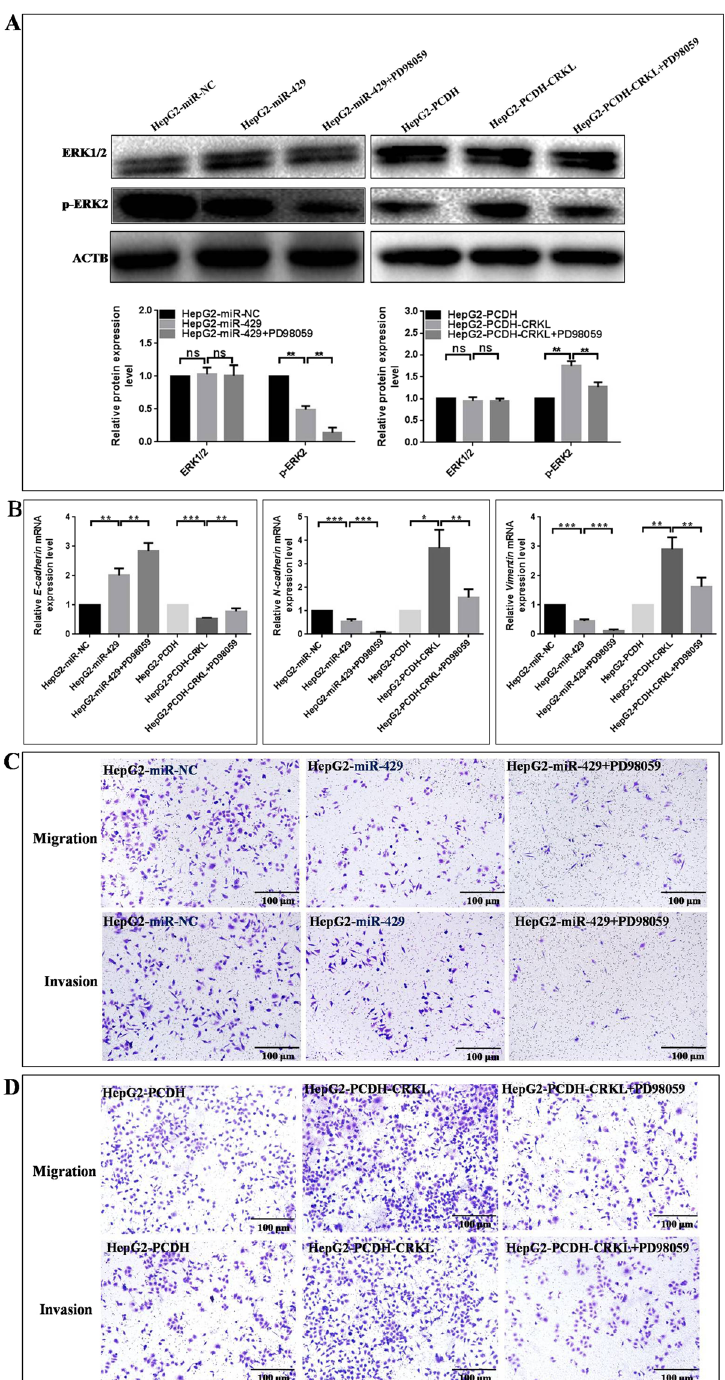
Figure 11. PD98059 influence on miR-429- and CRKL-induced Raf/MEK/ERK pathway and EMT. ( A ) WB assay of ERK and p-ERK2 level changes in HepG2-miR-429 and HepG2-PCDH-CRKL cells with PD98059 treatment for 48 h. ( B ) qRT-PCR assay of E-cadherin, N-cadherin, Vimentin changes in HepG2-miR-429 and HepG2-PCDH- CRKL cells with PD98059 treatment for 48 h. The influences of PD98059 on migration and invasion abilities of HepG2-miR-429 ( C ) and HepG2-PCDH-CRKL cells ( D ) *** and *** refer to the level changes were in statistical significances with P < 0.05, 0.01 and 0.001, respectively, ns refers to no statistical